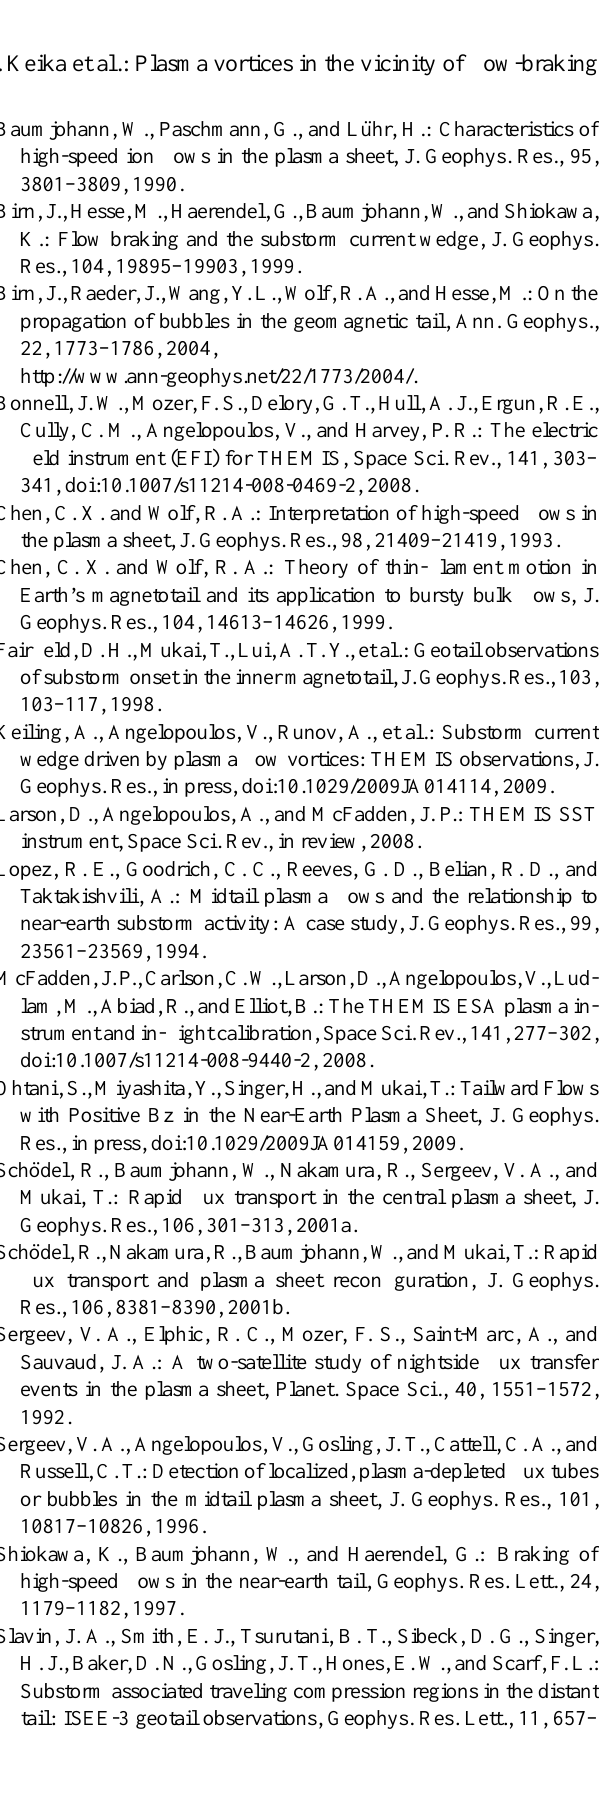
coordinates. Orange thin arrows indicate flow direction and strength (same as the right panels of Fig. 4a and b except for color). Red thick arrows present averaged direction and strength. Thin blue arrows indicate the magnetic field vari- ations, which are defined as deviations from the 5-min win- dow running average. Thick blue arrows show averages of the